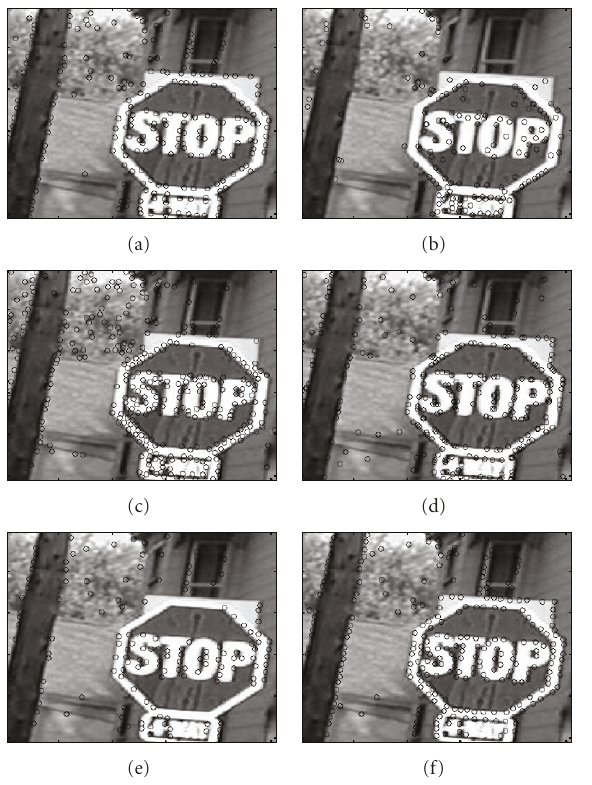
Figure 10: Feature points detected in 3.4 times scaled image by (a) Harris method (b) Lowe’s method, (c) Tomasi’s method, (d) Loupias’s technique, (e) Yeh’s algorithm, and (f) proposed